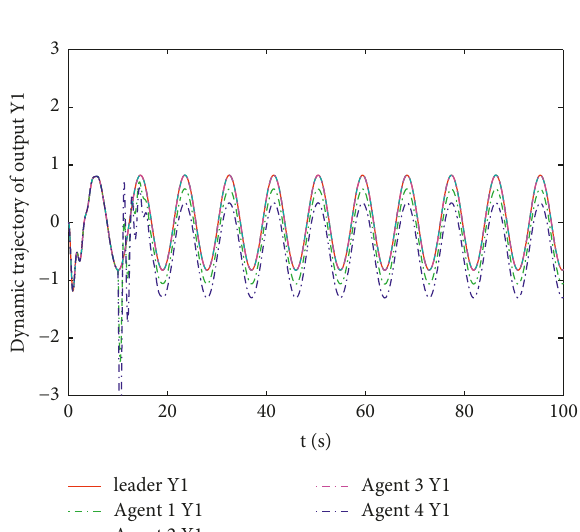
Figure 4: Profiles of output trajectories y